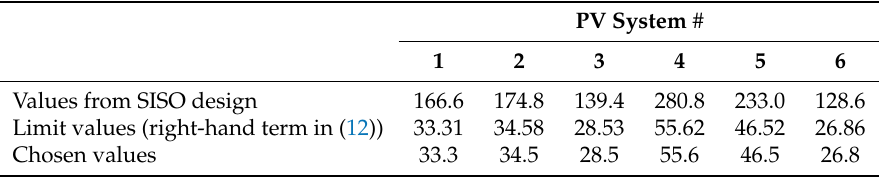
Table 2. Values of k ci for the voltage droop controllers